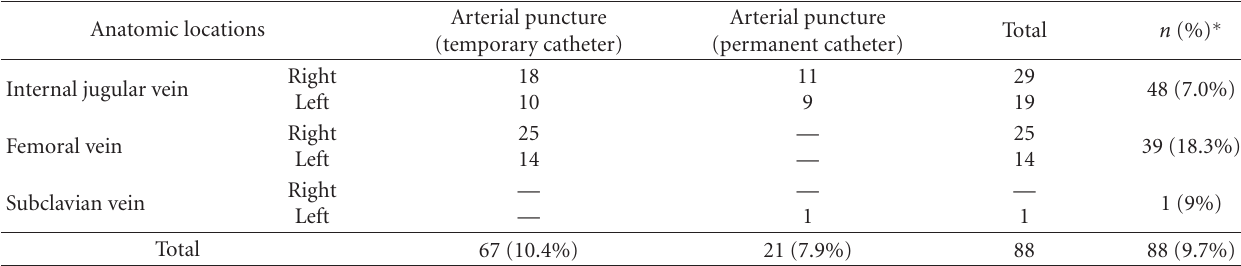
Table 2: Early complications of central venous